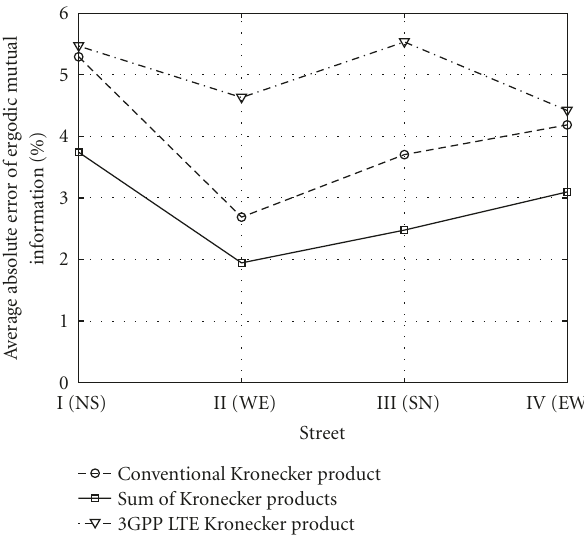
Figure 9: Average absolute errors of ergodic mutual information of the Laptop